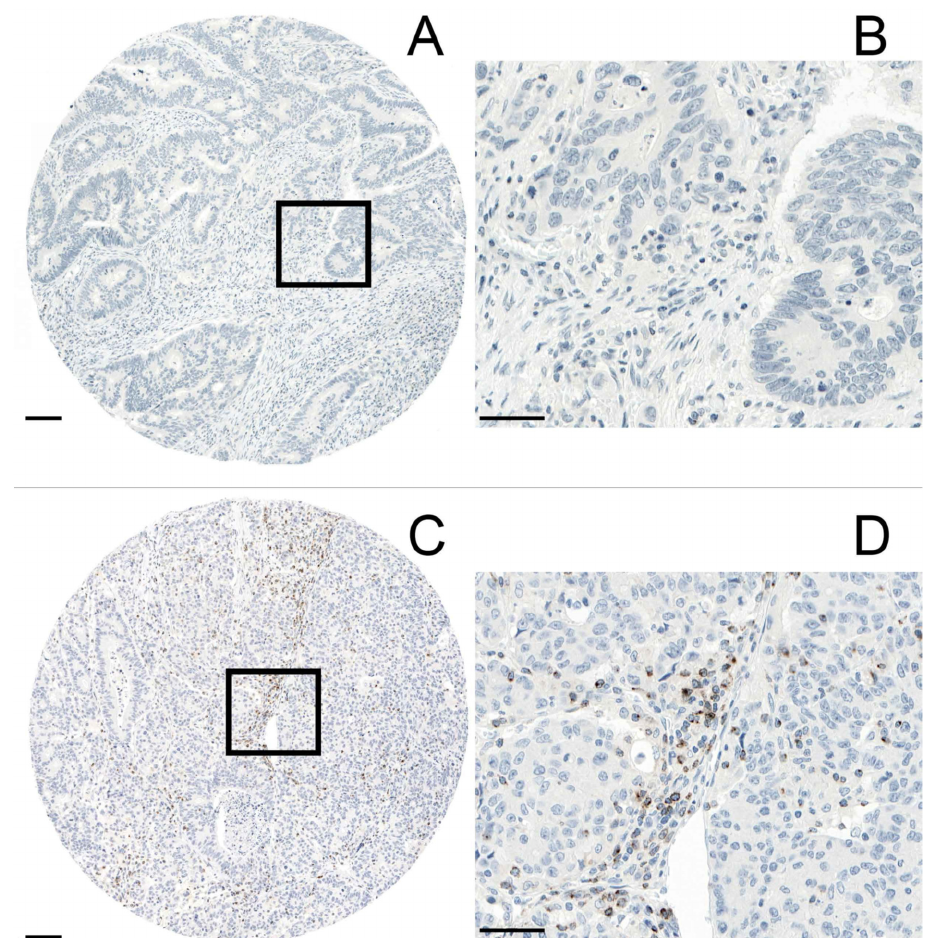
Figure 1. ( A , B ): Absence of immunohistochemical staining for LAG-3 on TILs (magnification: A 5 × and B 40 × ). ( C , D ): TILs expressing LAG-3 (magnification C 5 × and D 40 × ). Scale bar ( A , C ): 100 µ m. Scale bar ( B , D ): 50 µ m. All images ( A – D ) represent the tumor center.